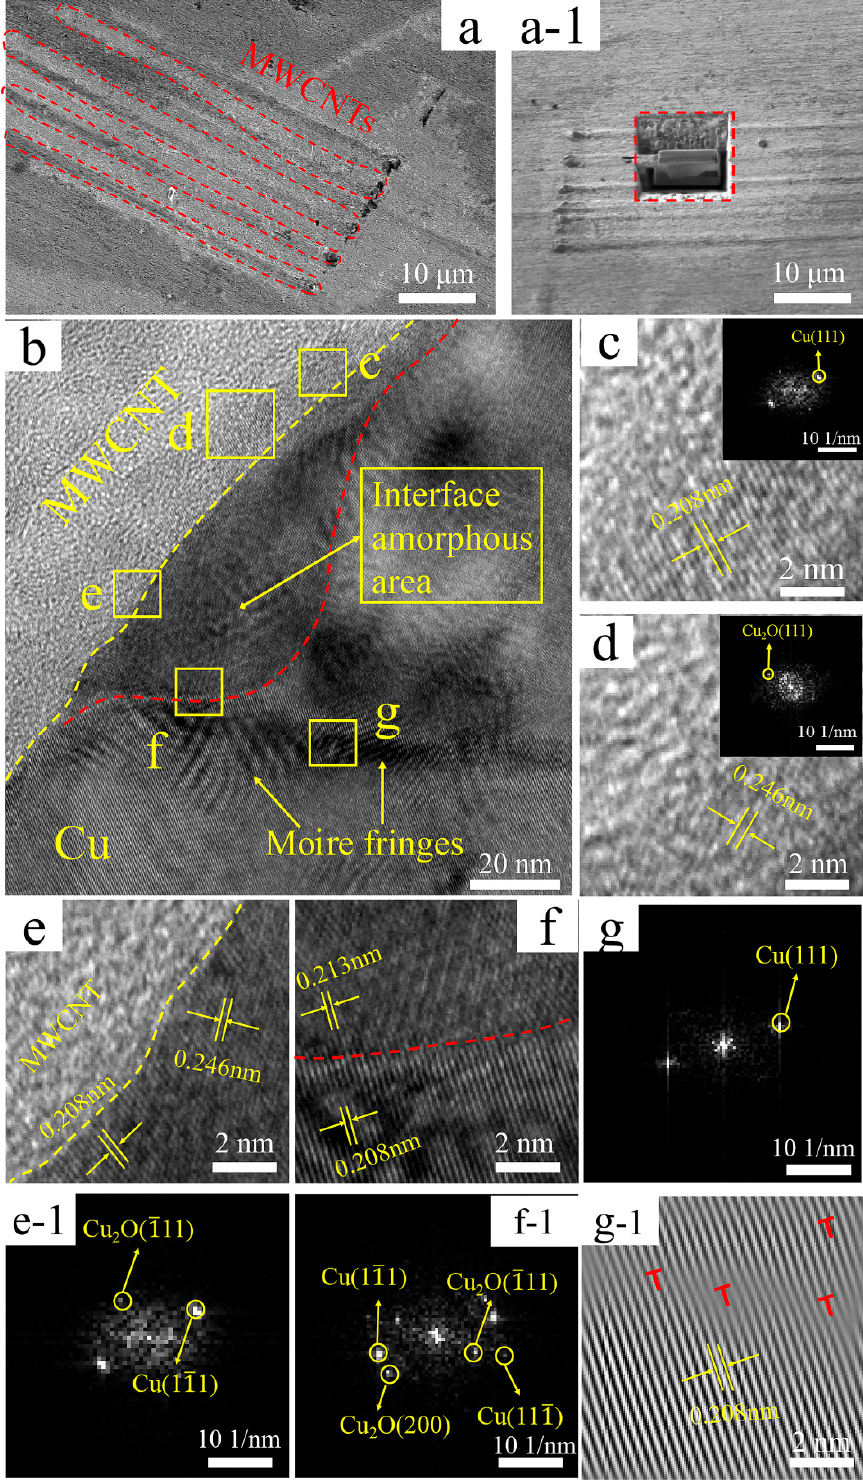
Figure 3. ( a ) SEM micrograph of Cu@MWCNTs/Cu composite, ( a-1 ) Sampling the manipulator at a, ( b ) TEM micrograph, ( c ) Enlarged view and FFT image of region c in b, ( d ) Enlarged view and FFT image of region d in b, ( e , e-1 ) Enlarged view and FFT image of region e in b, ( f , f-1 ) Enlarged view and FFT image of region f in b, ( g , g-1 ) FFT and IFFT image of region g in b, dislocations marked with ‘T’ symbols.